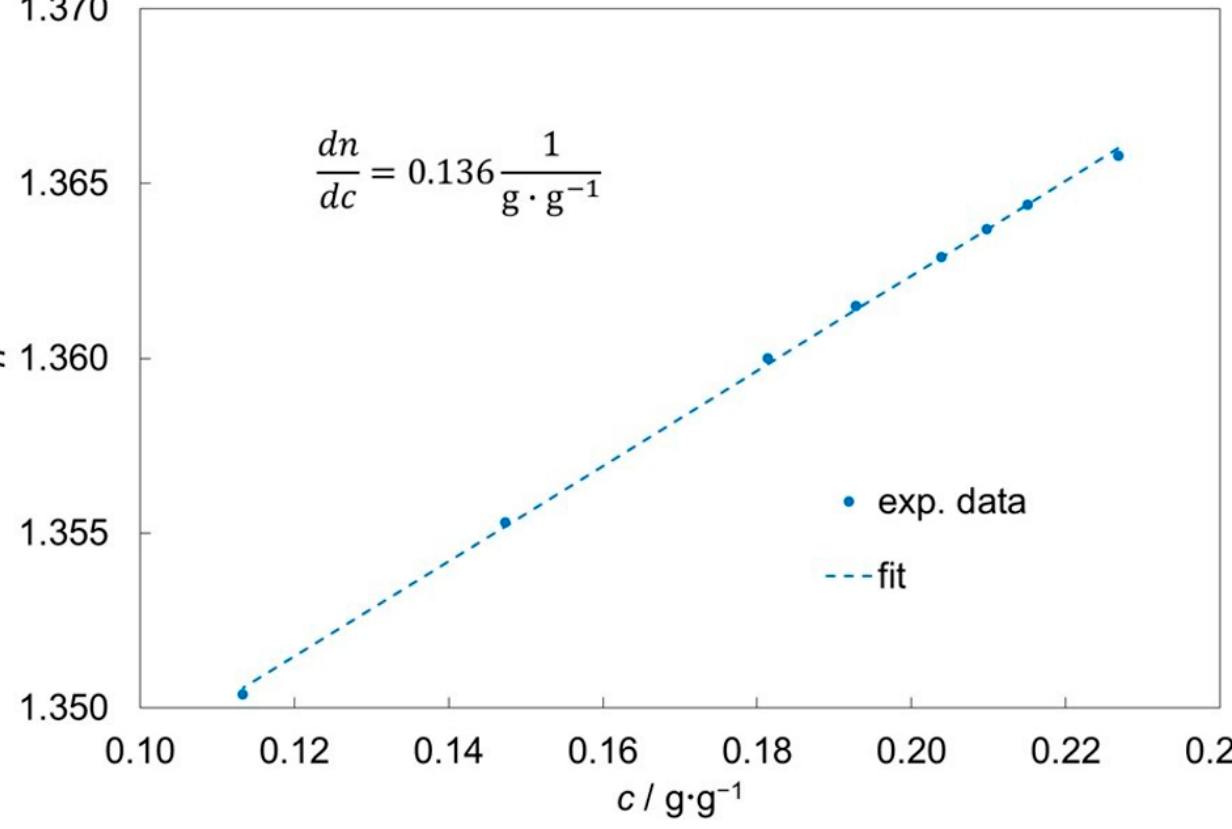
Figure 6. Refractive index of glycine solutions at 25 °C.